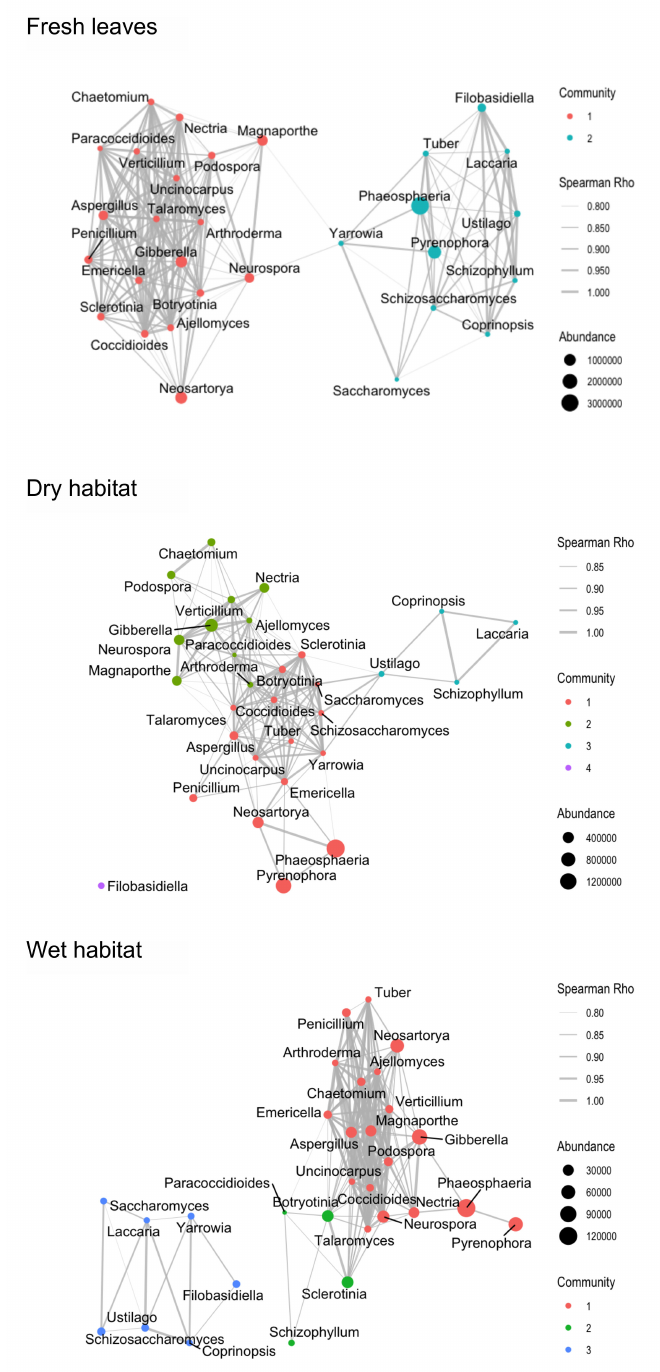
Figure 4. Co-occurrence patterns of fungal communities on fresh leaves and leaves decomposing in the dry and wet habitat visualising significant correlations ( ρ > 0.6, p < 0.05; indicated with grey lines) between fungal OTUs in leaves of Phragmites australis . Different colours of nodes represent individual modules within the community identified using the greedy optimisation of the modularity algorithm. The size of the nodes represents the abundance of sequences for the individual nodes. The weight of the edges represents the Spearman Rho for the individual